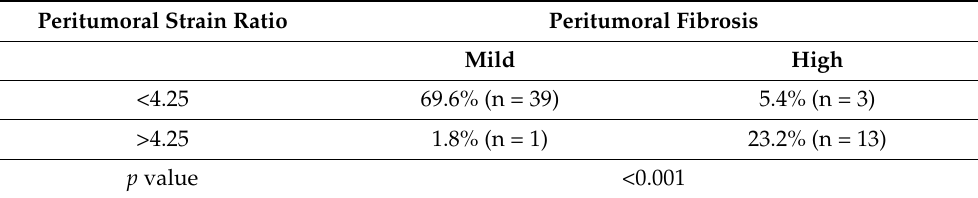
Table 4. Peritumoral strain ratio of malignant mammary carcinomas according to their histopatho- logical